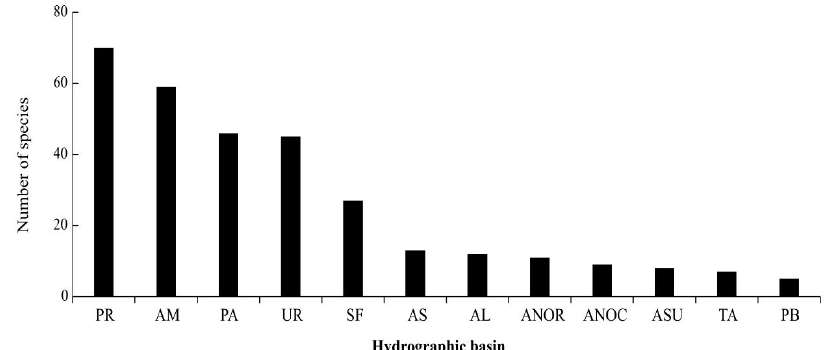
Figure 3. Number of freshwater fish species described as to their early development (eggs and/or larvae) in the different Brazilian river basins between 1977 and 2018. PR: Paraná; AM: Amazon; PA: Paraguay; UR: Uruguay; SF: São Francisco; AS: Southeast Atlantic; AL: East Atlantic; ANOR: Eastern Northeast Atlantic; ANOC: Western Northeast Atlantic; ASU: South Atlantic; TA: Tocantins-Araguaia and PB: Parnaíba.